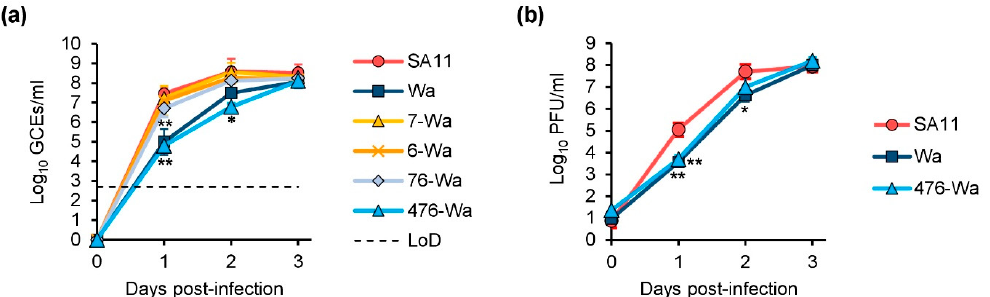
Figure 4. Replication kinetics in MA-104 cells. ( a ) Cells were infected with 2 × 10 4 GCEs and the number of GCEs/mL was determined by qRT-PCR at the indicated time points post-infection. Results are representative of three independent experiments. ** p < 0.01 for Wa or 476-Wa versus SA11. * p < 0.05 for 476-Wa versus SA11. ( b ) Cells were infected with a multiplicity of infection (MOI) of 0.003 and the number of PFUs/mL was determined by plaque assay. Results are representative of three independent experiments. ** p < 0.01 for Wa or 476-Wa versus SA11. * p < 0.05 for Wa versus SA11. Abbreviations: LoD = limit of detection; 4 = VP4; 7 = VP7; 6 = VP6.